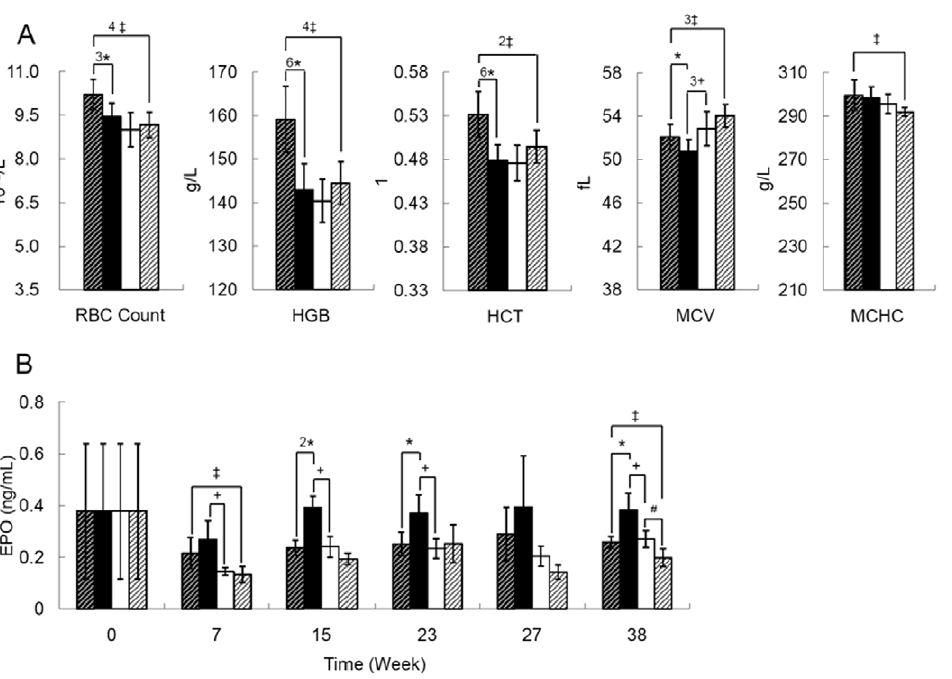
Figure 4. Evidence that CO treatment promotes increased erythropoiesis by an erythropoietin-independent mechanism. (A) Red blood cell indices of B6 mice on garlic-supplemented or garlic-free (cellulose-supplemented) diets with or without the treatment of CO at week 38: red blood cell concentration (RBC count, 10 12 /L), hemoglobin concentration (HGB, g/L), hematocrit (HCT, %), mean corpuscular volume (MCV, fL), mean corpuscular hemoglobin concentration (MCHC, g/L). Statistics: + , Air-Cellulose (AC) vs . Air-Garlic (AG); { , CO-Cellulose (COC) vs . CO-Garlic (COG); * CO-Cellulose (COC) vs . Air-Cellulose (AC); # , Air-Garlic (AG) vs . CO-Garlic (COG). One symbol, p , 0.05; 2 symbols, p , 0.01; 3 symbols, p , 0.005; 4 symbols, p , 0.001; 6 symbols, p , 0.0001 (student’s t test); n=7–10. The arrangements for each block of bars are (left to right): thick cross-hatched bars, cellulose diet and treated with CO (COC); filled bars, cellulose diet and treated with air (AC); open bars, garlic diet and treated with air (AG); thin cross-hatched bars, garlic diet and treated with CO (COG). (B) Plasma erythropoietin (EPO) levels (ng/mL), n=4 for each set of samples at different point of the time course. Symbols are the same as those in Panel A. The pairwise comparisons between AC and COG are: week 7, p , 0.013; week 15, p , 0.003; week 23, p =0.065; week 27, p =0.084; week 38, p , 0.007 (student’s t